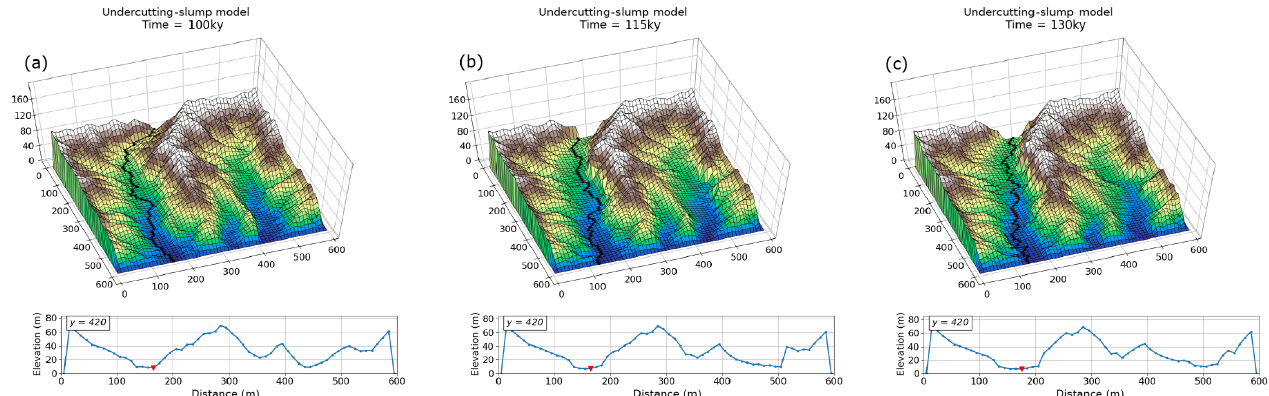
Figure 9. Surface topography and cross section at y = 420 during the period of increased water flux for the undercutting-slump models. The red triangle on cross sections indicates the channel position. (a) Undercutting-slump model with low K and K l /K v = 1 . 5 at 100kyr before the increase in water flux. Valley is 30m wide. (b) After 15kyr of increased water flux, the channel has both vertically incised and laterally widened the valley to a width of 40m. (c) After 30kyr of increased water flux, the valley has a width of 60m at y = 420.